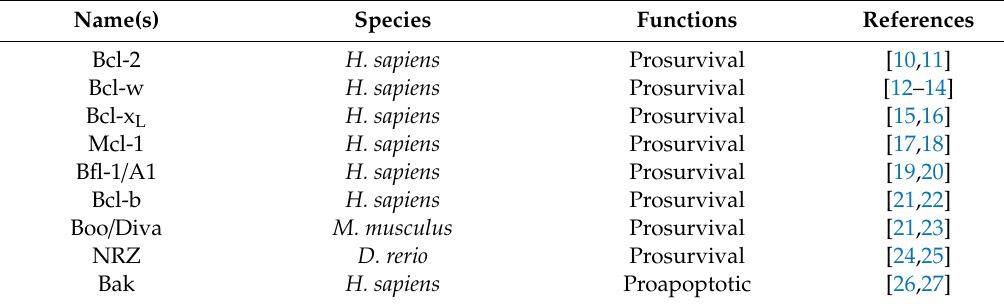
Table 1. Summary of Bcl-2-related proteins and their activities.